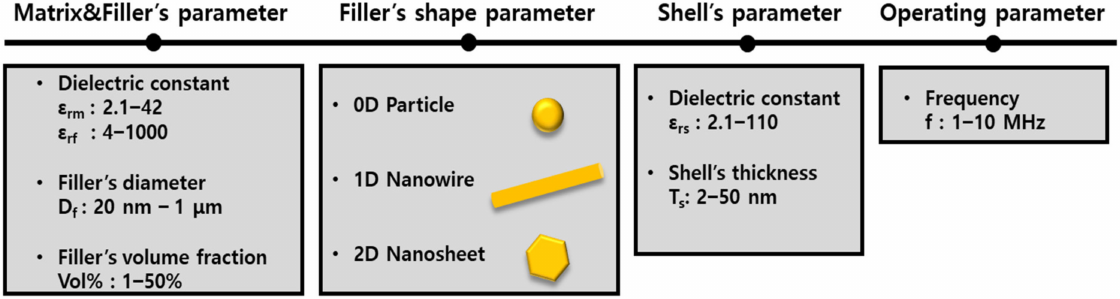
Figure 1. Schematic of the input parameters in the machine learning.